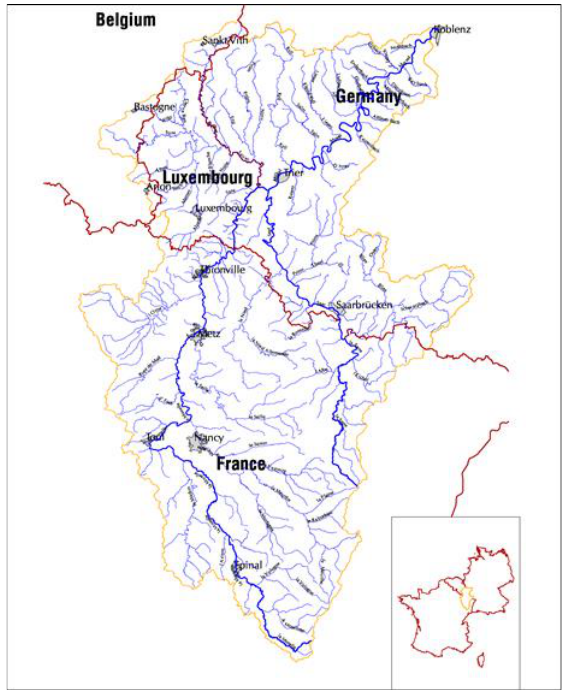
Figure 2. Map of the Mosel – Saar Transnational Basin (France, GD Luxembourg and Germany). The Mosel (at the West) and Saar (at the East) rivers are marked in dark blue lines, light blue lines represent tributaries, red lines are the borders and yellow line is the International Mosel-Saar Basin boundary.